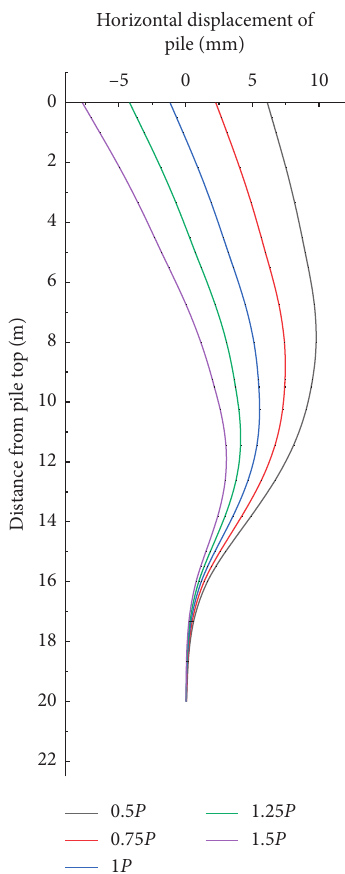
Figure 8: Horizontal displacement of the pile.